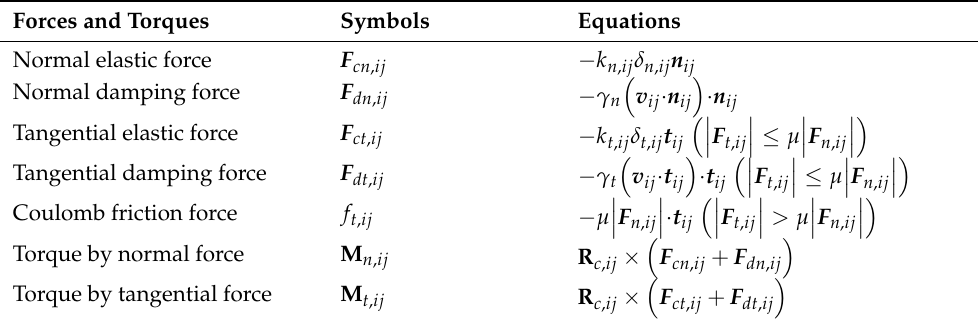
Table 2. Components of forces and torques acting on